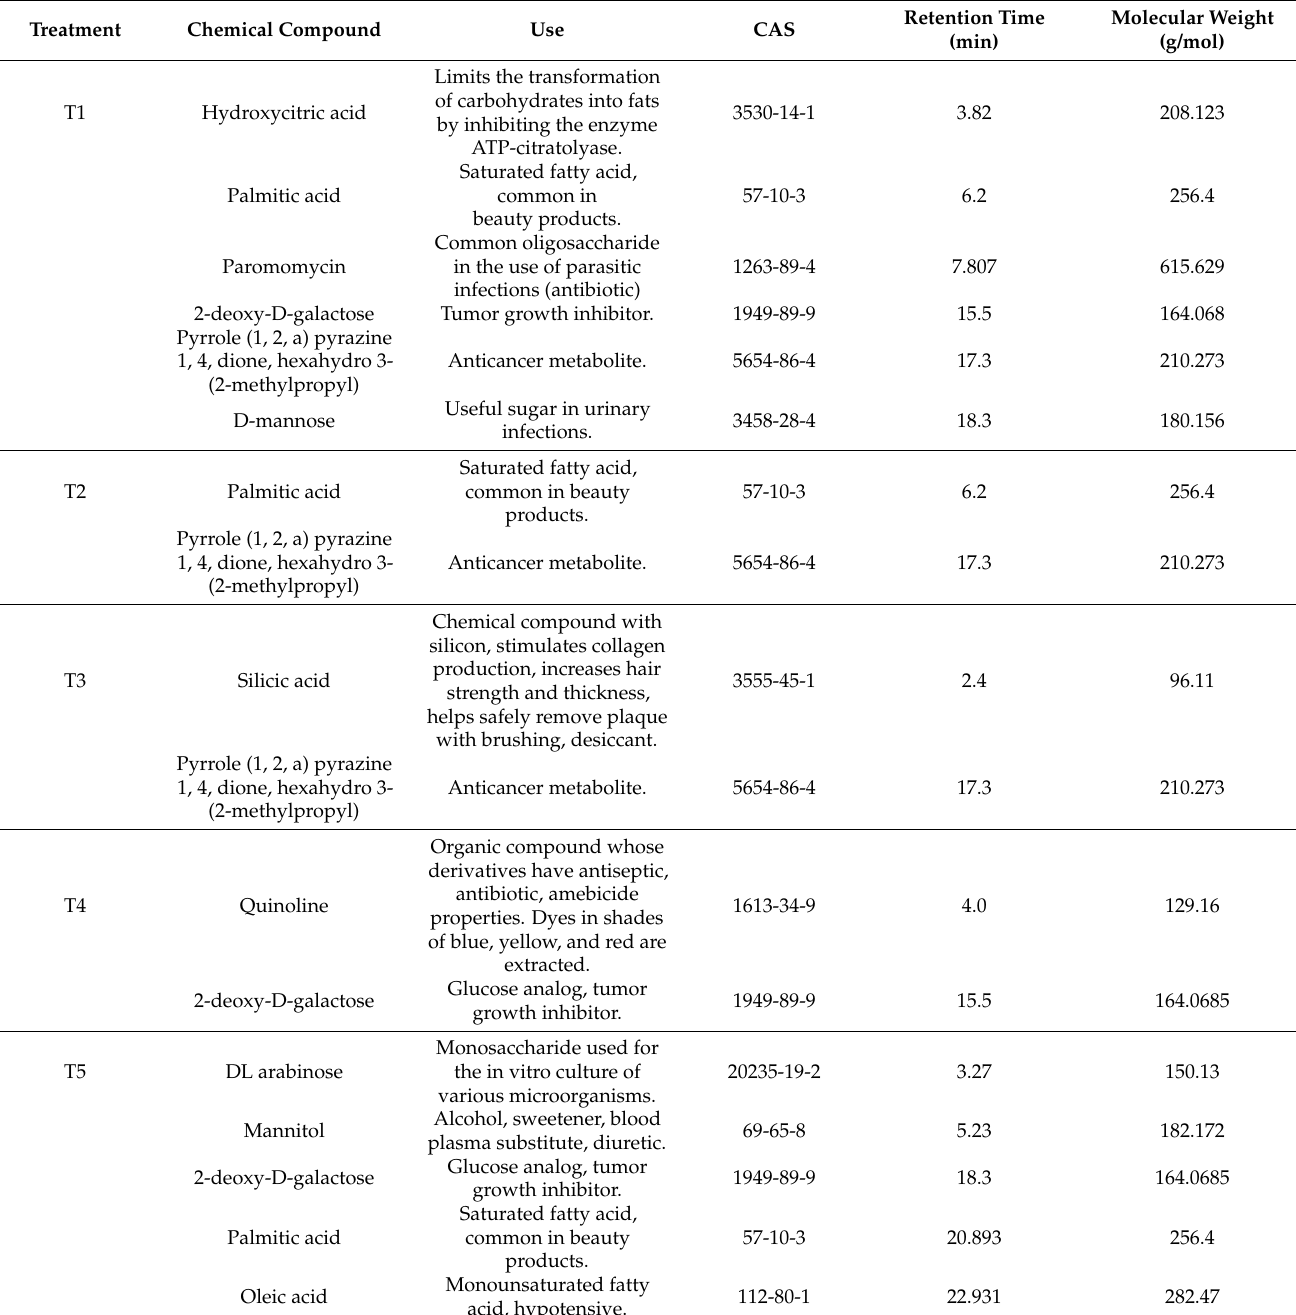
Table 3. Chemical compounds identified in P. djamor